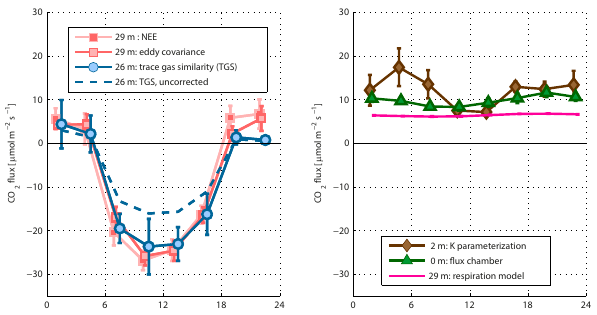
Figure 8. Comparison of summertime CO 2 fluxes (15–22 July 2011 period) throughout the forest canopy: net ecosystem exchange (NEE), trace gas similarity via H 2 O (corrected and uncorrected; Sect. 4.2), eddy covariance (eddy), K parameterization, flux cham- bers, and respiration model. Data points represent 3h aggregate mean and 95% confidence